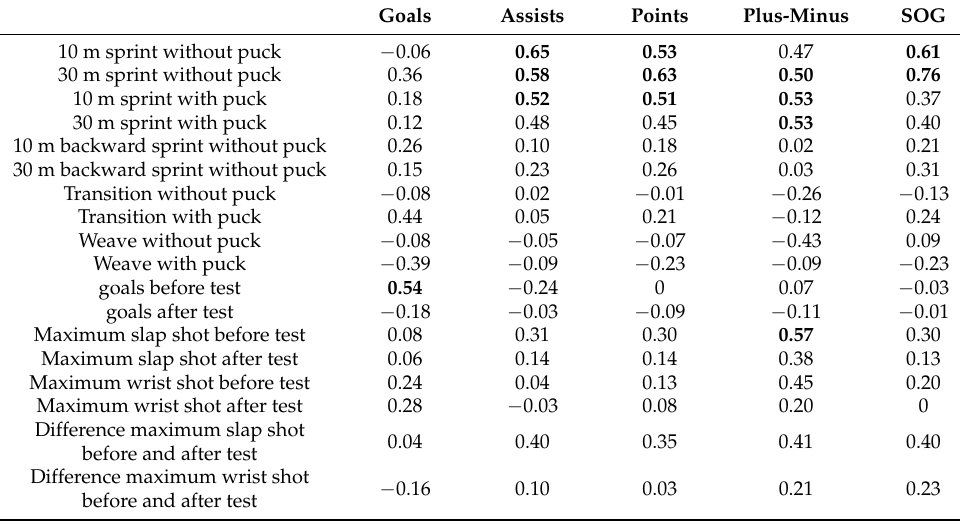
Table 6. Bivariate correlations (r) between on-ice testing variables (load parameters) and selected match performance variables. Relevant correlations (r ≥ 0.5) marked in bold. SOG = shots on